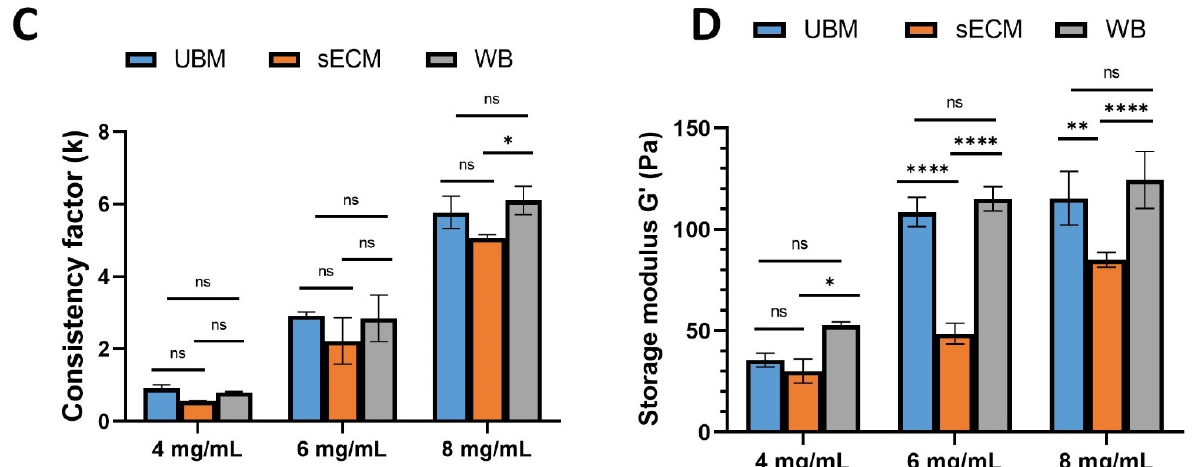
Figure 3. Shear thinning properties of the pregel solution ( A ). Representative curve of rheologic gelation of hydrogel ( B ). Consistency factor of the pregel solution ( C ). Storage modulus (G’) of the hydrogels ( D ). *, **, **** denote statistical difference within the same group with p < 0.05, 0.01, 0.0001, respectively ( n = 3).